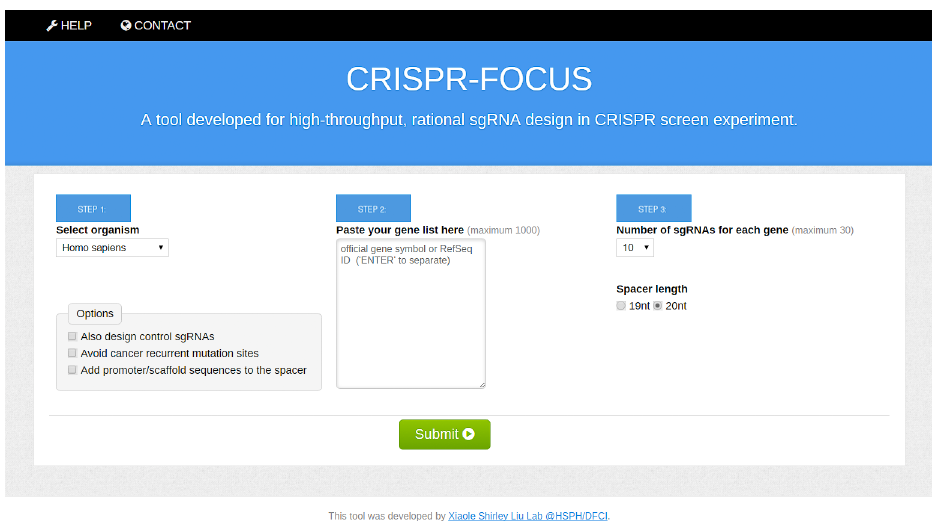
Fig 3. The main user interface of CRISPR-FOCUS. A screenshotof the CRISPR-FOCUS website (http:// cistrome.org/crispr-focus/)) is shown.